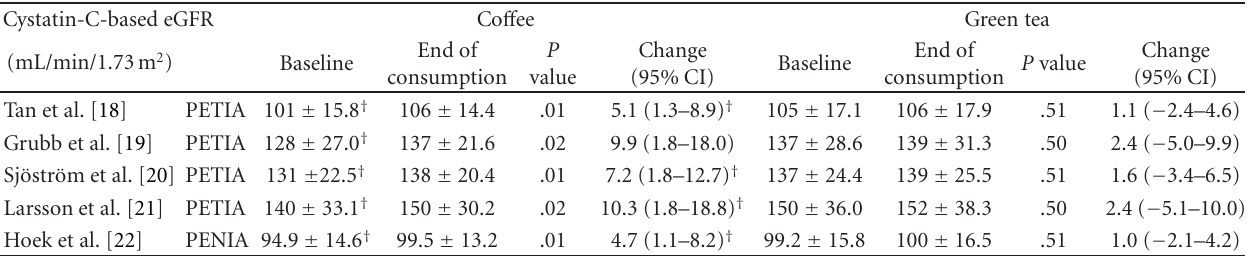
Table 3: Di ff erence in cystatin-C-based eGFR (determined using five di ff erent equations) between the start and end of each consumption